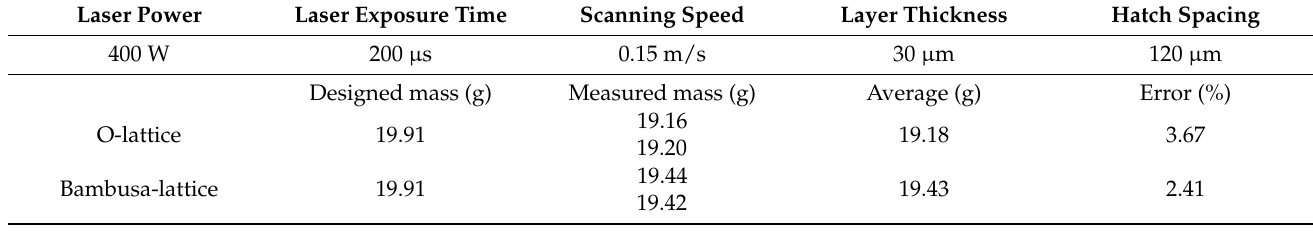
Table 1. Design dimensions of the la tt ice structure.